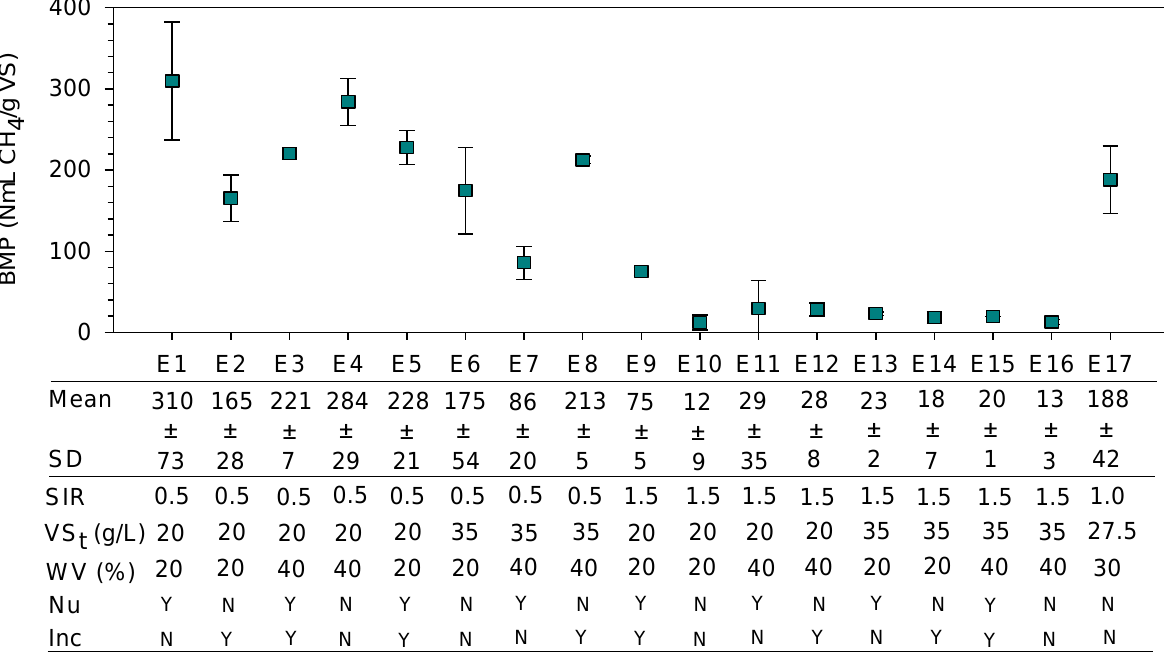
( b ) Figure 2. ( a ) Statistical significance of the terms included in the complete 2nd-order factorial model. ( b ) Comparison be- tween predicted and experimental BMP values obtained from the 2 5 − 1 fractional factorial design. Four sets with intermediate levels of operating conditions were performed to validate the obtained model. The experimental data are presented in Figure 2b as blue squares. Four points are clearly far from the predicted BMP, indicating a lack of fit of the model for the respective operating conditions. These experiments were carried out with an SIR of 1.25, which may have caused the observed discrepancy. As previously stated, the SIR has a significant effect on the model. In fact, the assays performed with an SIR of 1.5 were revealed as unfavorable, and the tests with an SIR of 1.0 showed high uncertainties. How- ever, the validation experiments with an SIR of 0.75 were well predicted by the model